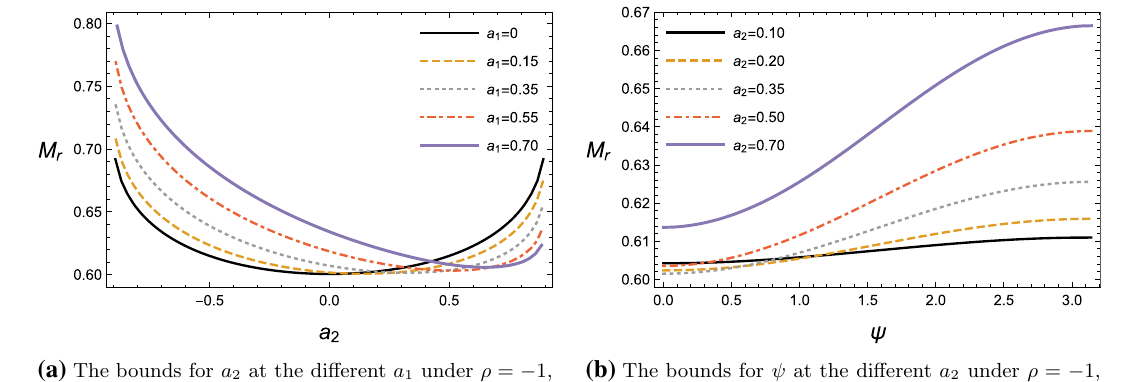
(b) The bounds for ψ at the different a 2 under ρ = − 1, g = 0 . 5, M 1 = 1, and M 2 = 1.